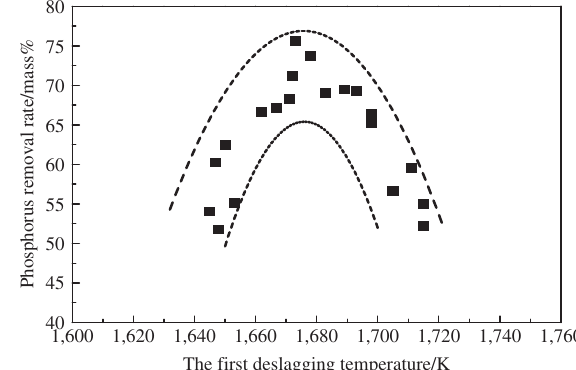
Figure 1: Dependence of dephosphorization rate on temperature of the first